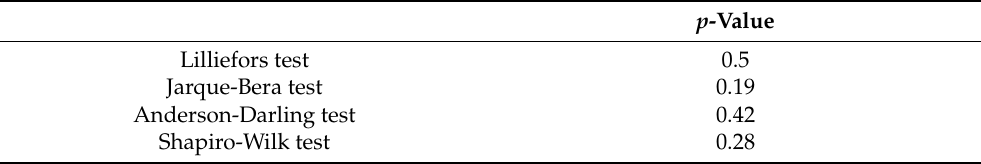
Figure 7. ( a ) PDF; ( b ) CDF. Table 8. The p -values for normality tests. Table 8. The p -values for normality tests.